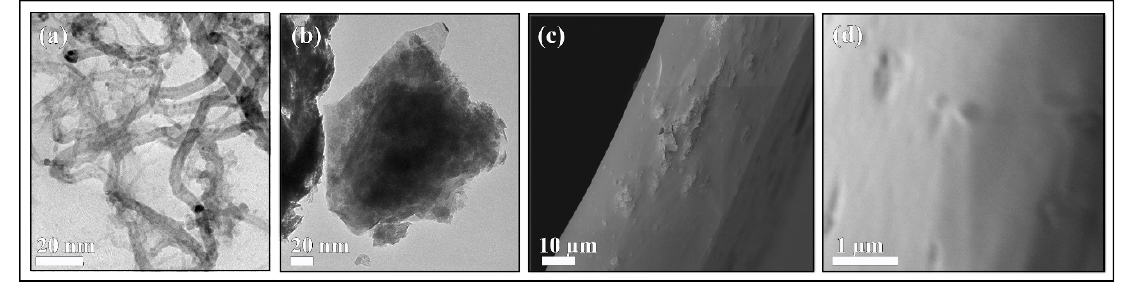
Figure 1. Electron microscopy images: ( a ) HR-TEM of one-dimensional carbon nanofibers, ( b ) HR-TEM of two-dimensional graphene oxide nanosheets, FESEM of ( c ) cross section (at 1000x) and ( d ) surface (at 11160x) of calcium alginate composite films with 1% w/w of graphene oxide.